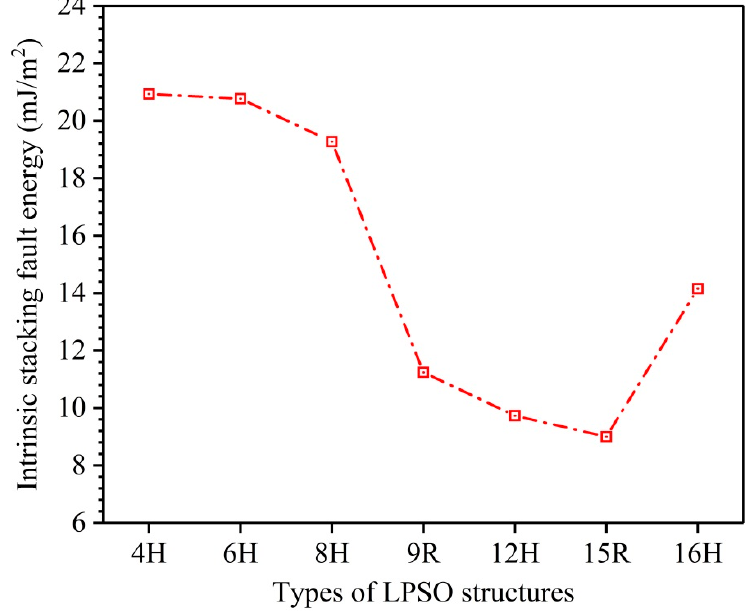
Figure 2. Comparisons of calculated ISFEs for 4H, 6H, 8H, 9R, 12H, 15R, and 16H phases.